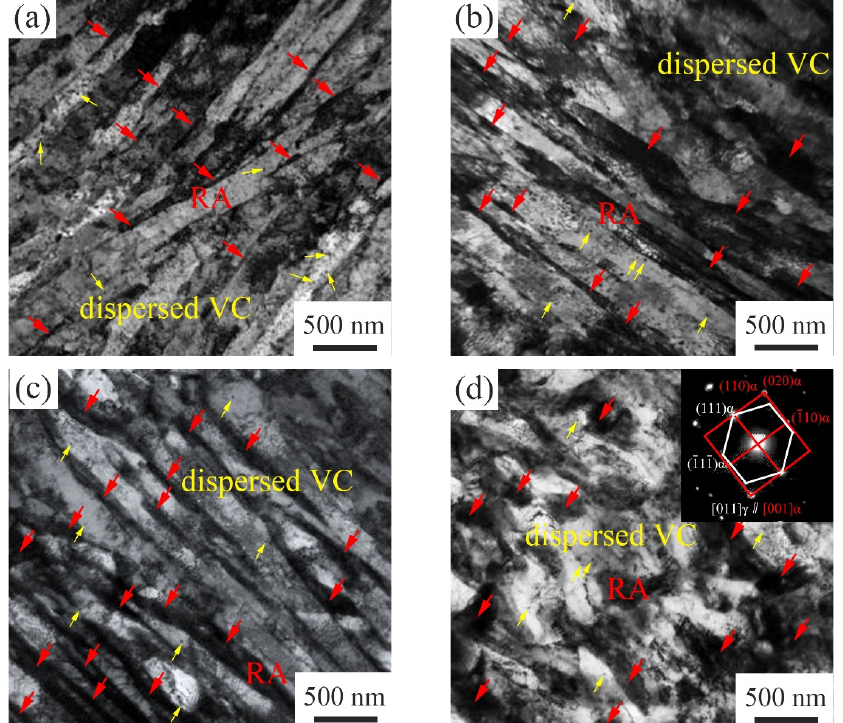
Figure 8. TEM images and the selected area electron diffraction pattern: ( a ) 600 °C; ( b ) 620 °C; ( c , d ) 650 °C.